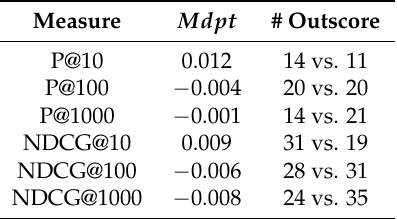
Table 20. T1: Porter/DirichletLM+QE+RF run vs. RR fusion of DirichletLM+QE+RF model with the four indexes.